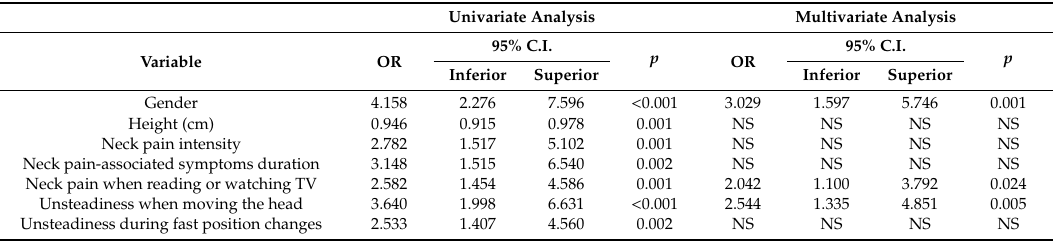
Table 2. Univariate and multivariate logistic regression to analyze the factors related to the presence of headache.